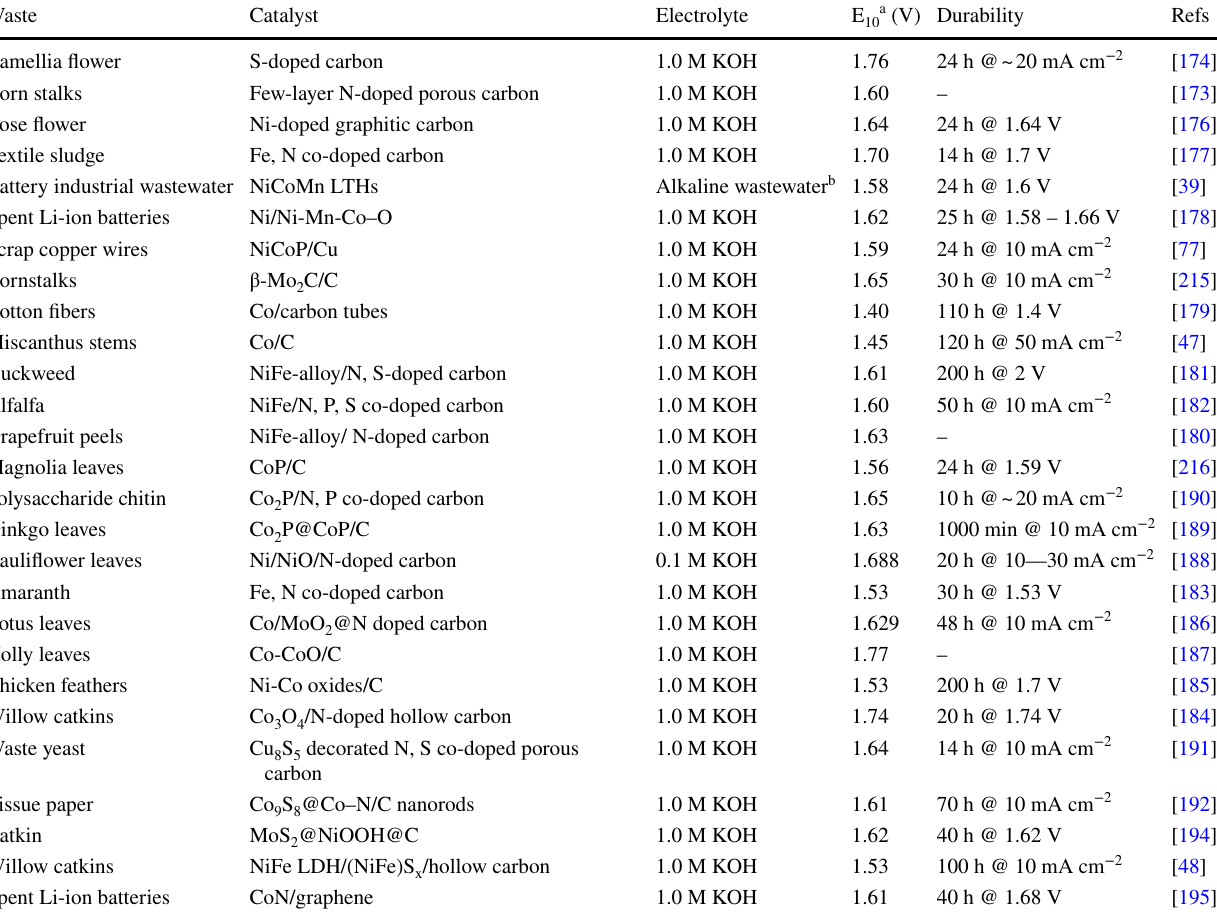
Table 3 Summary of representative waste‑derived electrocatalysts for